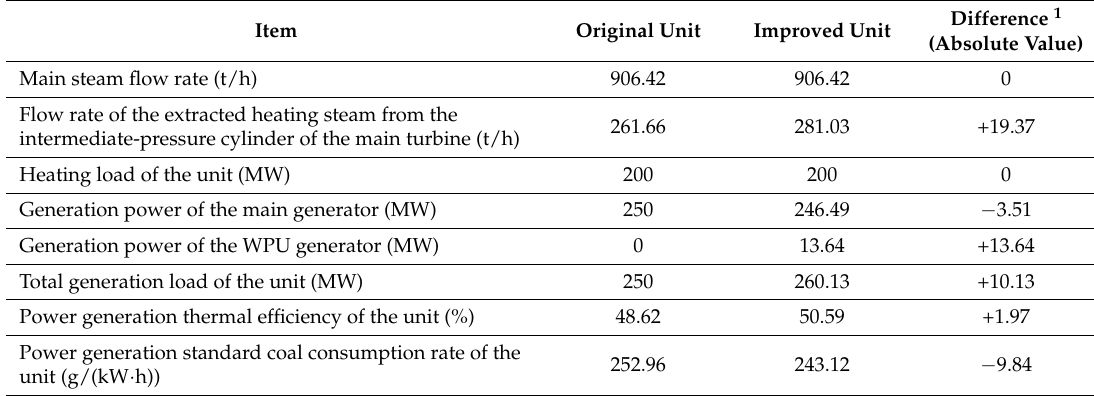
Table 4. Overall performances of the original and improved CHP units.